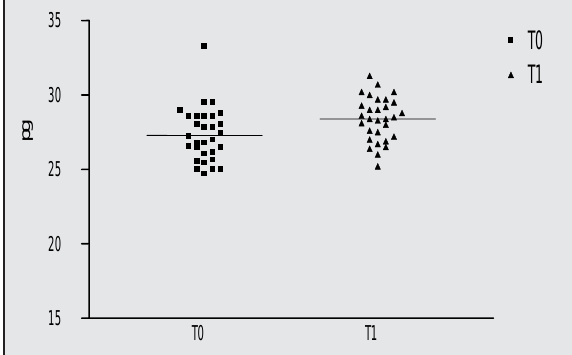
Figura 4 – Distribuição dos valores de HCM das pacientes antes (T0) e após (T1) a reposição hormonal. Observa-se aumento significativo ( p < 0,05) da hemoglobina corpuscular média após o tratamento. A barra horizontal representa a média